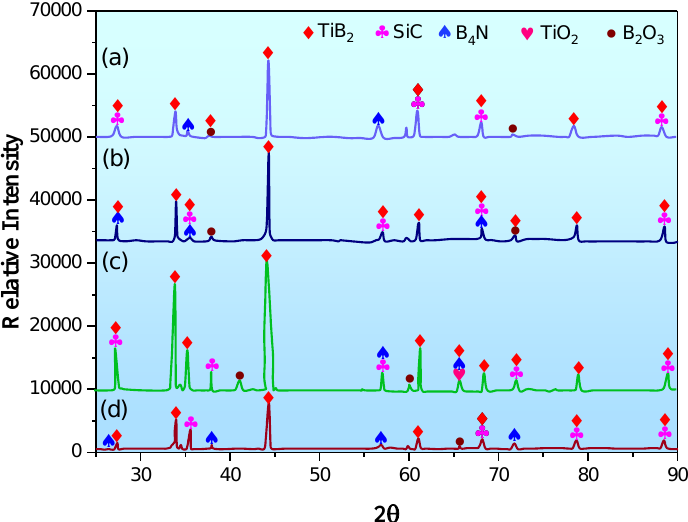
Figure 5. Relative intensity of mixed powders as given by XRD: ( a ) TiB 2 -15Si 3 N 4 -3B 4 N, ( b ) TiB 2 -